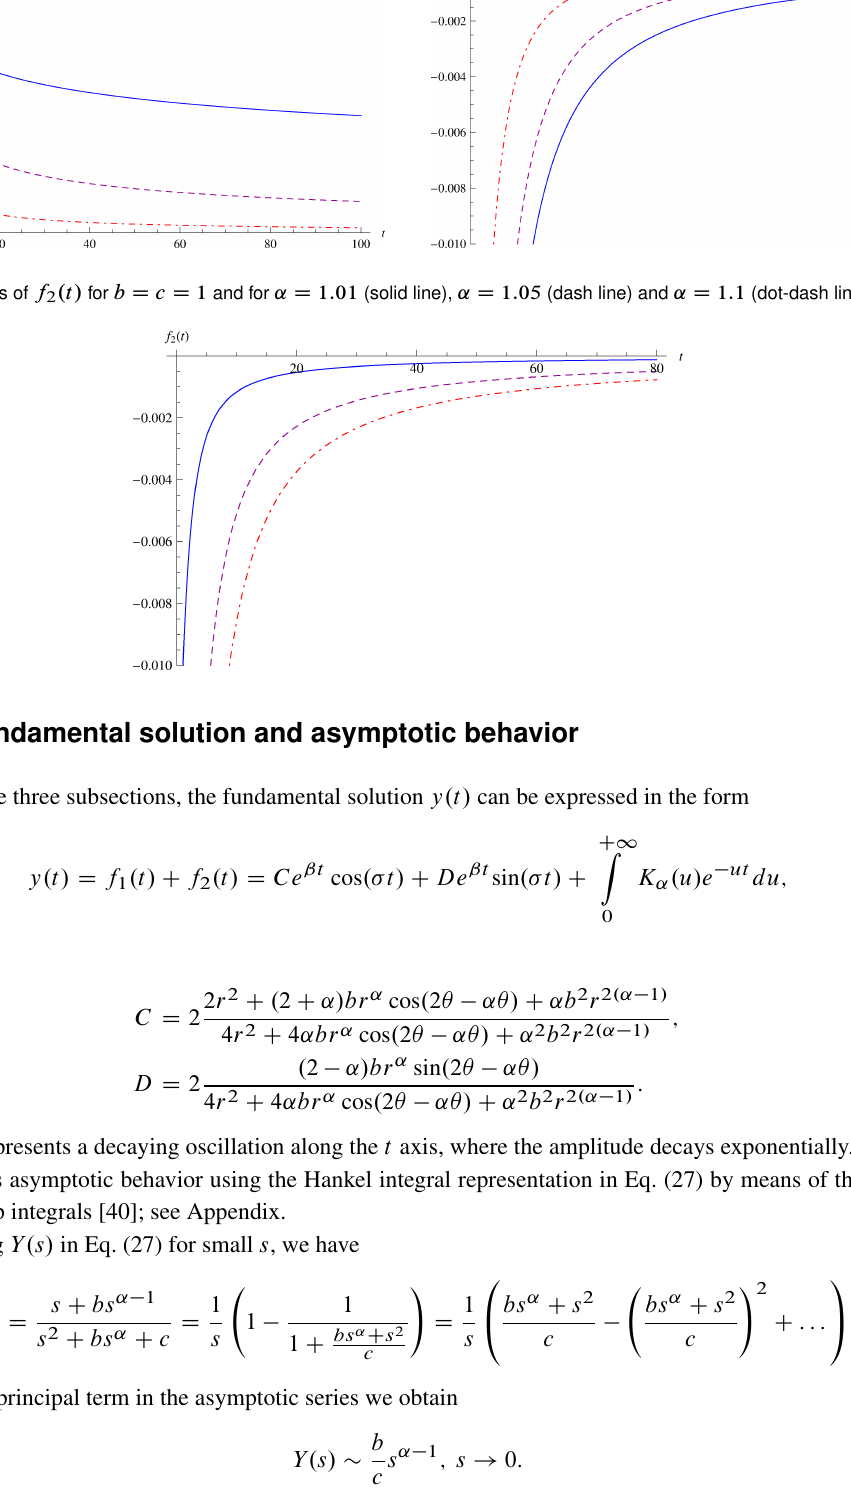
Fig. 5. The curves of f 2 .t/ for b D c D 1 and for ˛ D 1:25 (solid line), ˛ D 1:5 (dash line) and ˛ D 1:75 (dot-dash line).